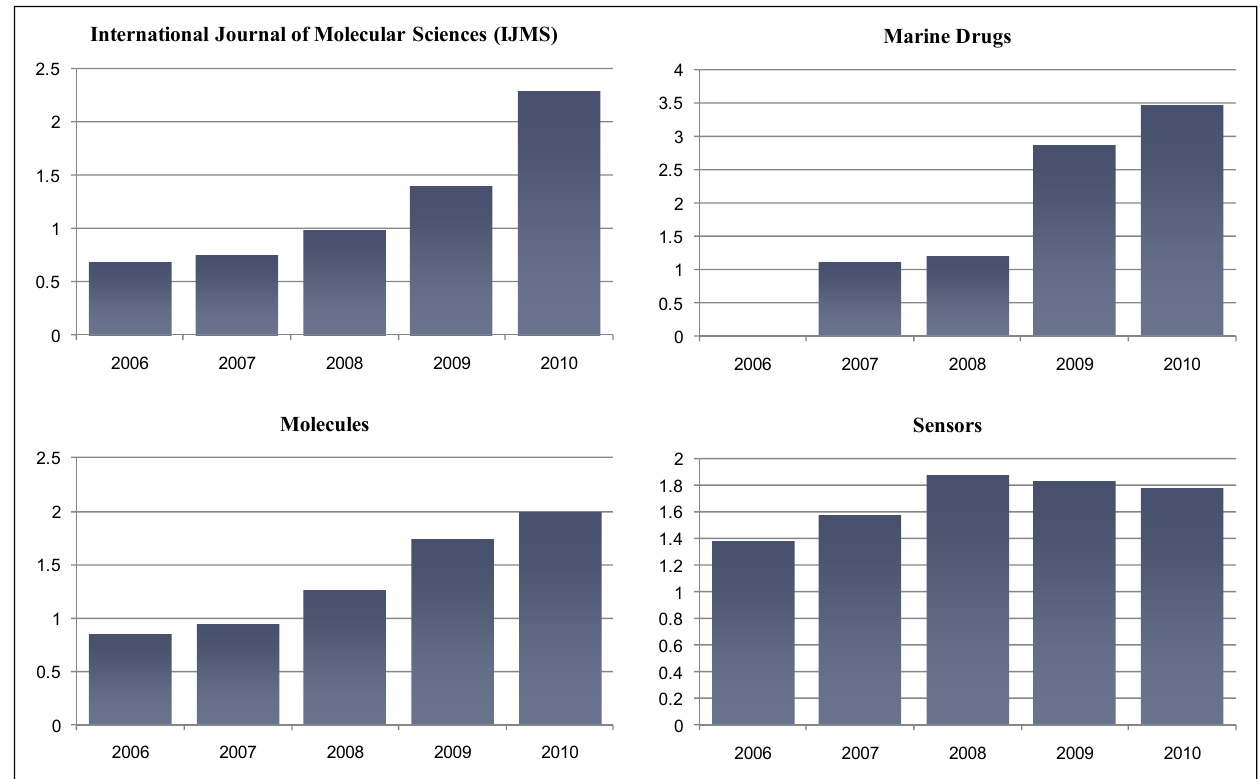
Figure 1. Evolution of the Impact Factors for four MDPI open access journals [adapted from the Journal Citation Reports (JCR), Edition 2010, Copyright 2011 by Thomson Reuters].